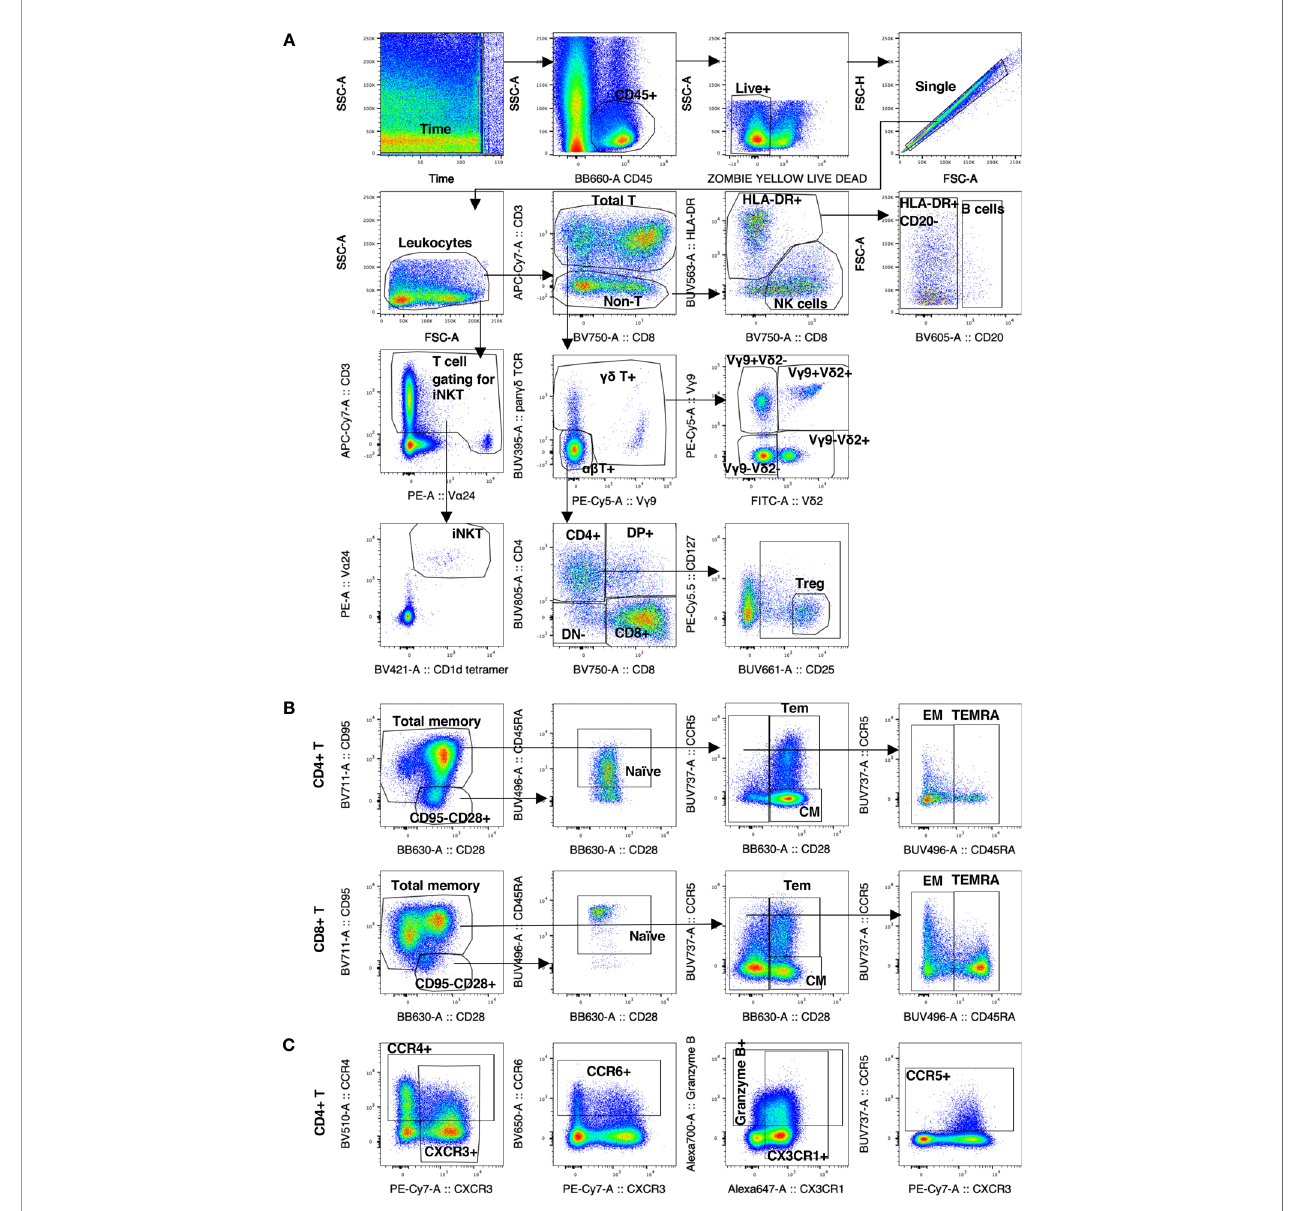
FIGURE 1 | Gating strategy of decidual leukocytes and PBMC in normal rhesus macaques. (A) Gating strategy in 28-color panel to identify ab T cells, NK cells, B cells, myeloid cells (HLA-DR+ CD20-), iNKTs, gd T cells, Tregs. (B) Gating strategy in CD4+ T and CD8+ T to delineate the naïve memory T cells subsets of CM, Tem, EM, and TEMRA. (C) Gating strategy of chemokine receptor